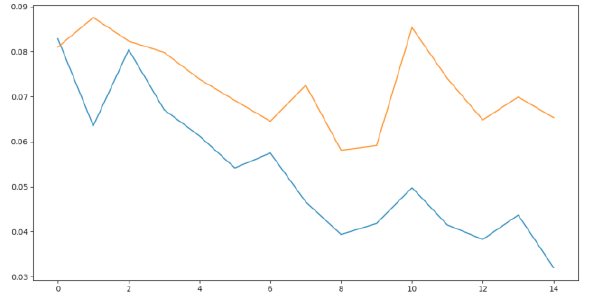
Fig. 10. Learning error on real sized problem.